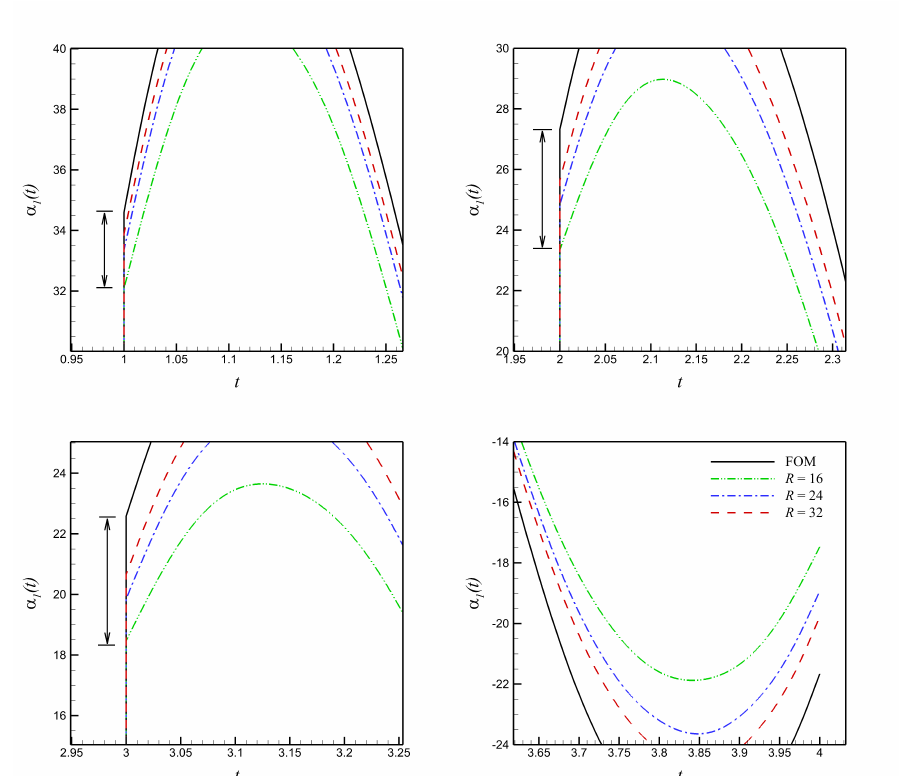
Figure 8. Close-up views of temporal coefficients at the interfaces for P = 4